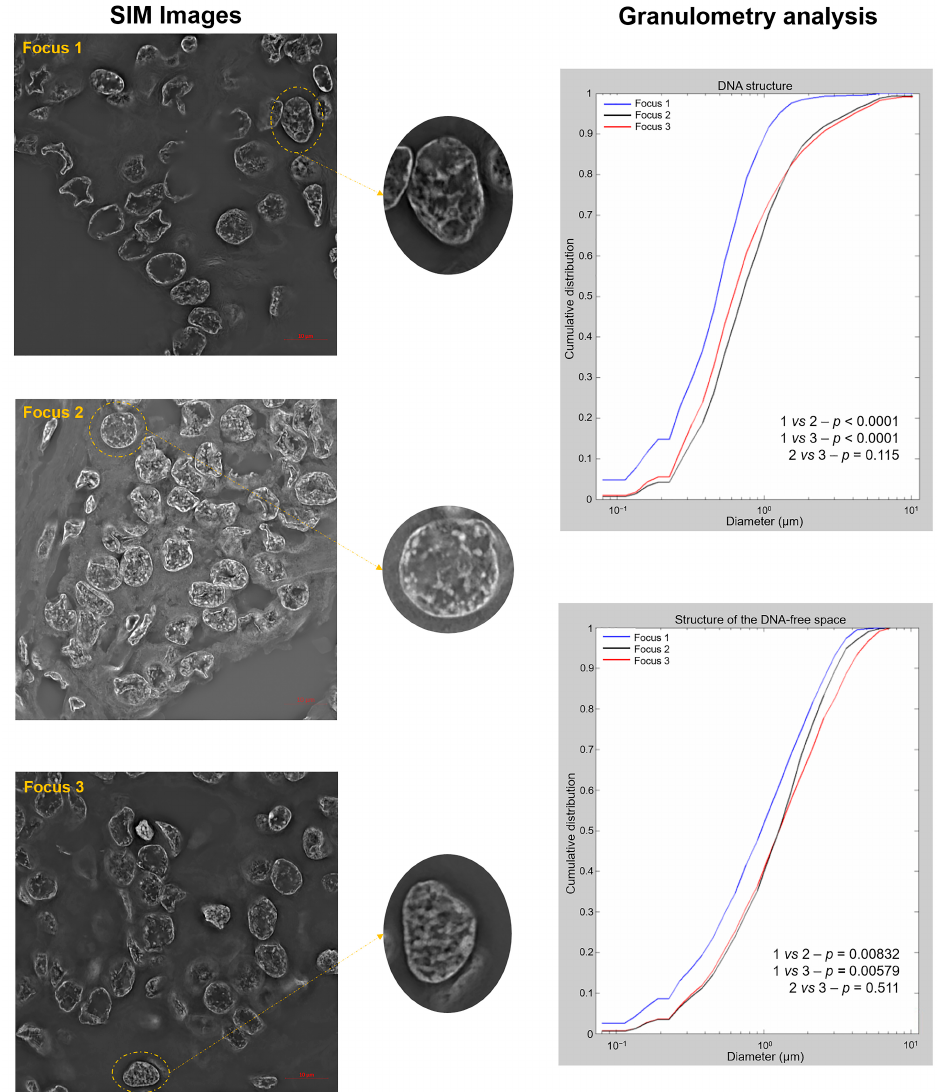
Figure 3. Representative Structured Illumination Microscopy (SIM) images for foci 1, 2 and 3 ( left panel ) and the granulometry comparisons between the foci for DNA structure ( right top panel ) and DNA-poor spaces ( right bottom panel